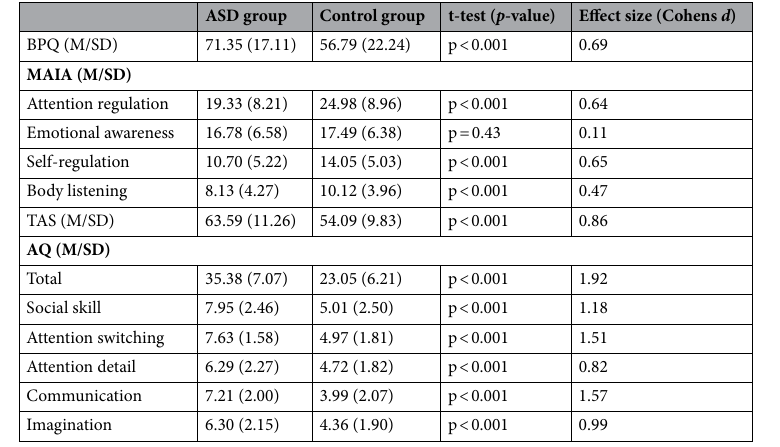
Table 2. Means and standard deviations of scale scores for ASD and control